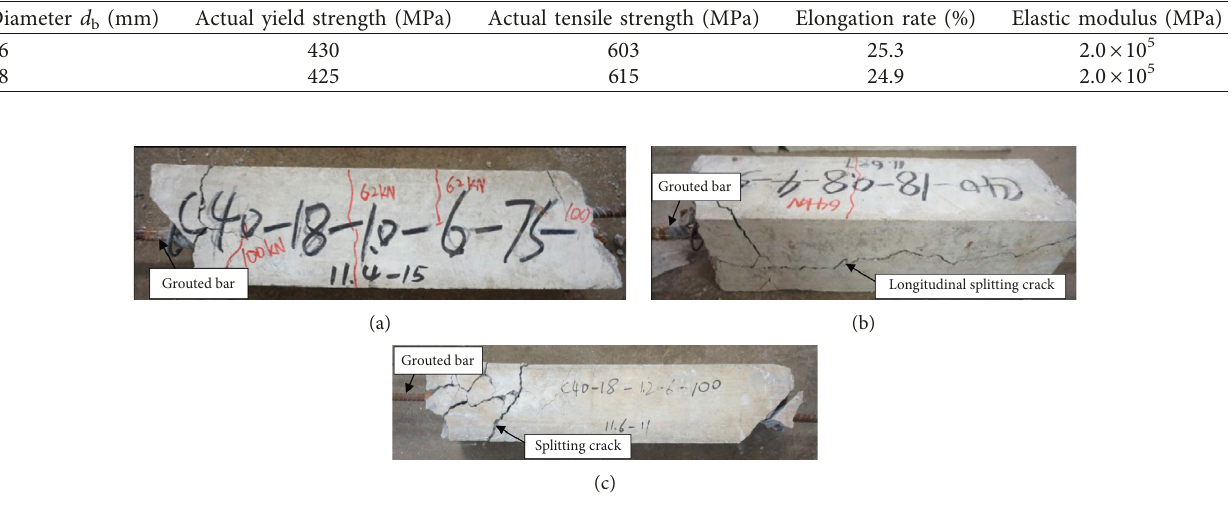
Figure 4: Typical cracking after load. (a) C40-18-1.0-6-75. (b) C40-18-0.8-4-50. (c)